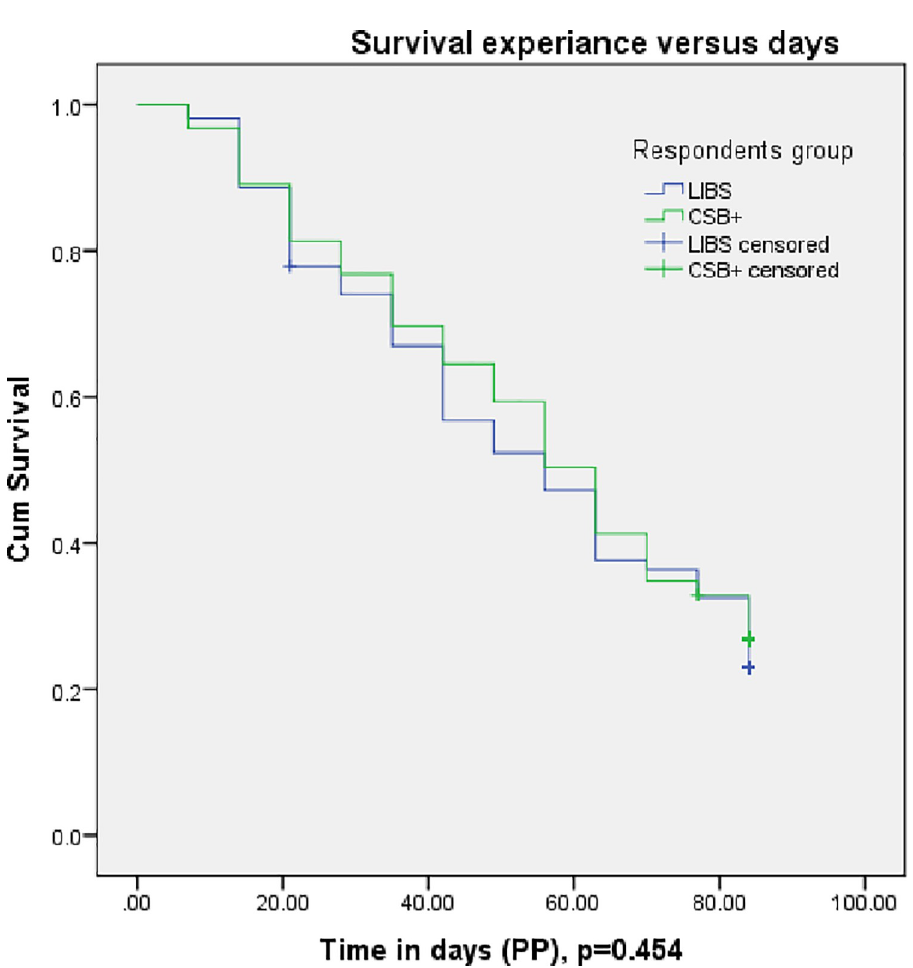
Fig 6. Recovery of children with moderate acute malnutrition over time in the LIBS and CSB+ arms in PP analysis. The recovery of children with MAM over time in the LIBS group was similar to the CSB+ group. Survival analysis, Kaplan-Meier curves, and Log-rank tests were used to analyze and describe the data. Abbreviations: MAM: moderate acute malnutrition; LIBS: local-ingredients-based supplement; CSB+: corn-soy blend plus; PP: per-protocol.